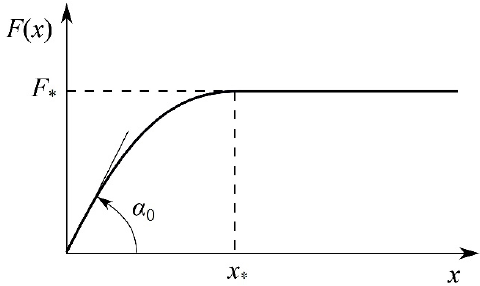
Fig. 1 Backbone curve for the Masing model of the tangential reaction of a fretting contact